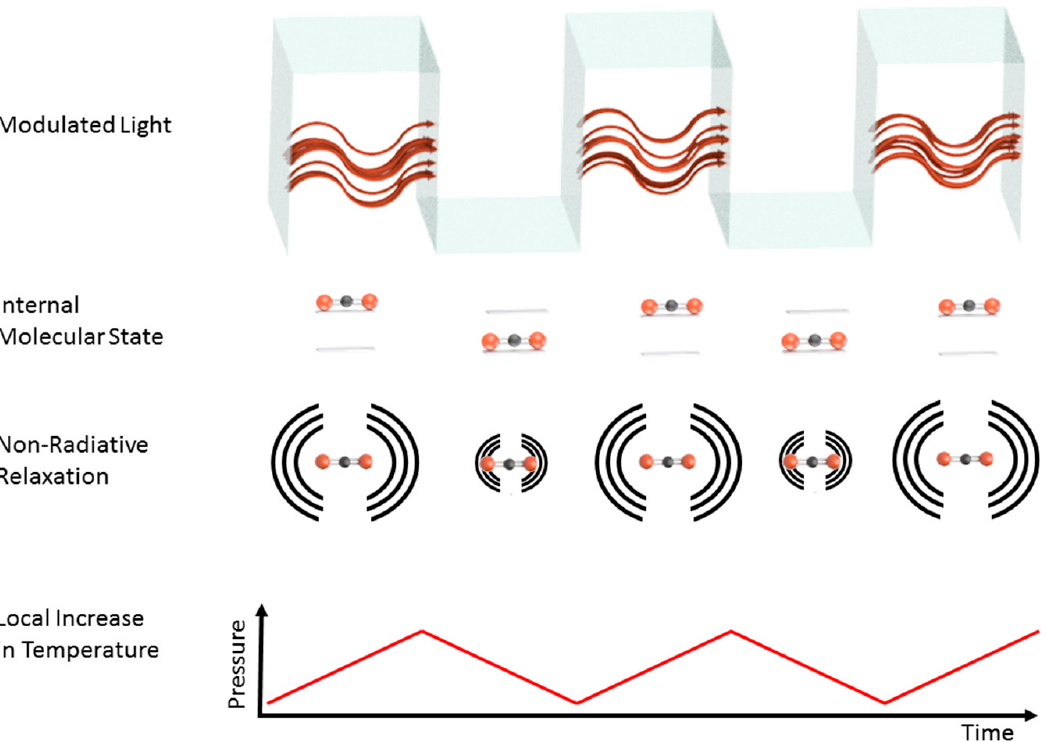
Figure 1. Simplified schematic depiction of the most relevant processes for photoacoustic signal generation. Intensity modulation of radiation excites internal molecular states. Due to non-radiative relaxation processes, part of the photon energy is converted into heat, leading to a local increase in temperature and pressure. Periodic light modulation thus leads to a pressure wave that may be detected using suitable transducer elements.